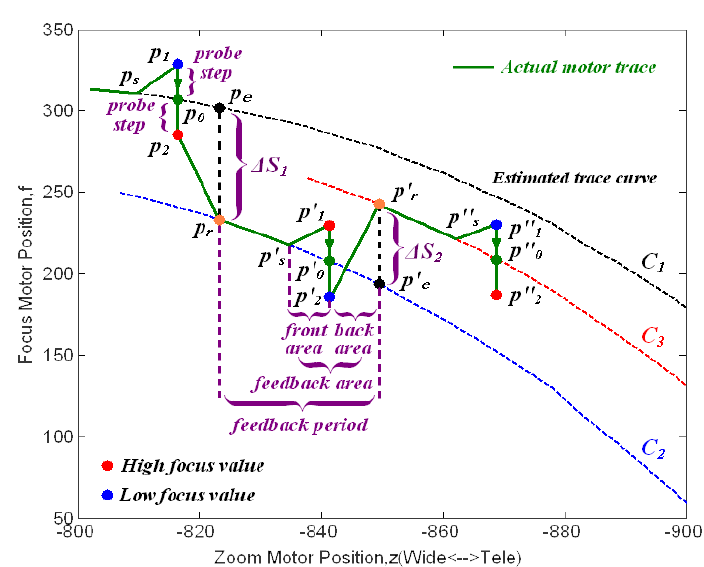
Figure 9. Illustration of FZT